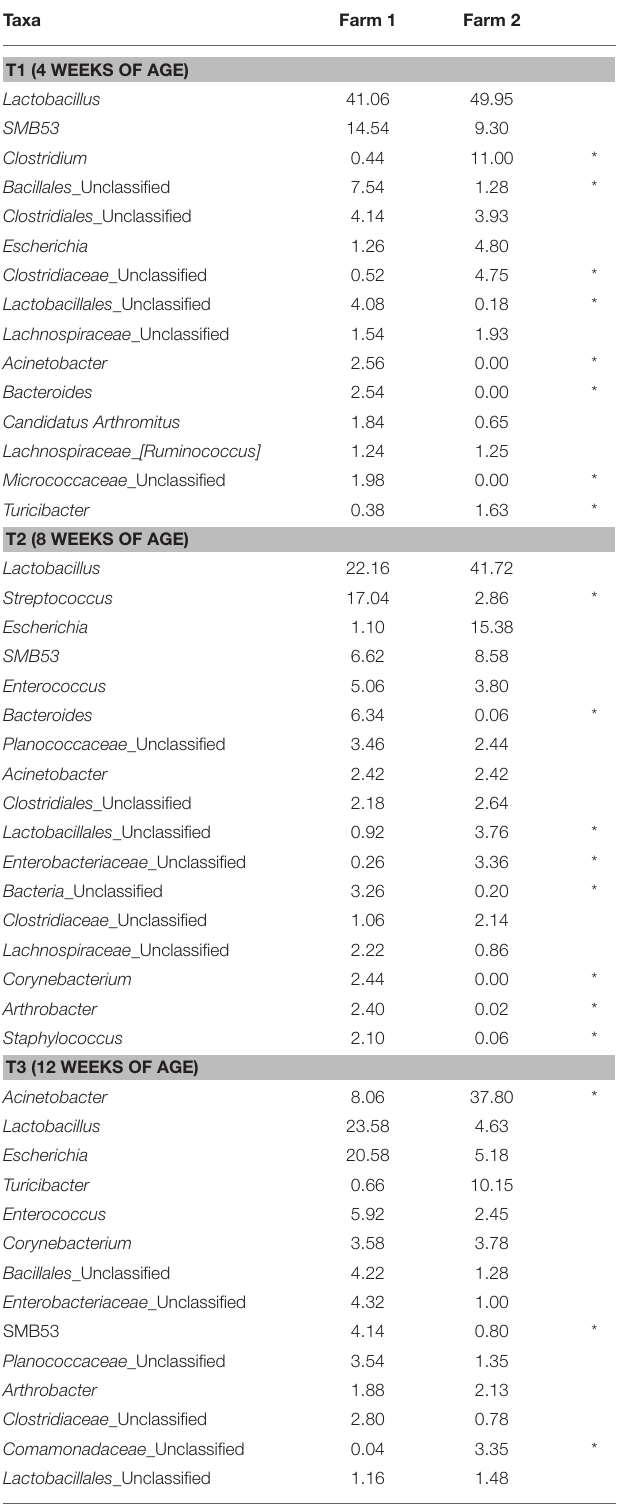
( Table 2 ). The processing WCR microbiomes from both farms shared the same dominant phyla, with Proteobacteria (89.2